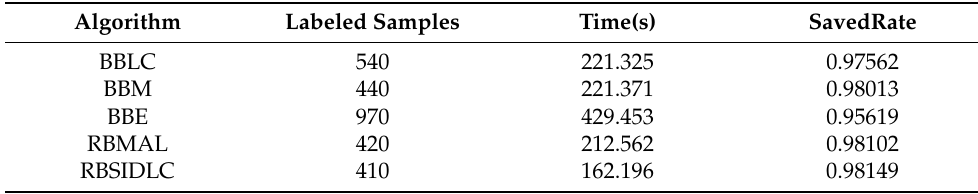
Table 7. Cost evaluation of five active learning methods with